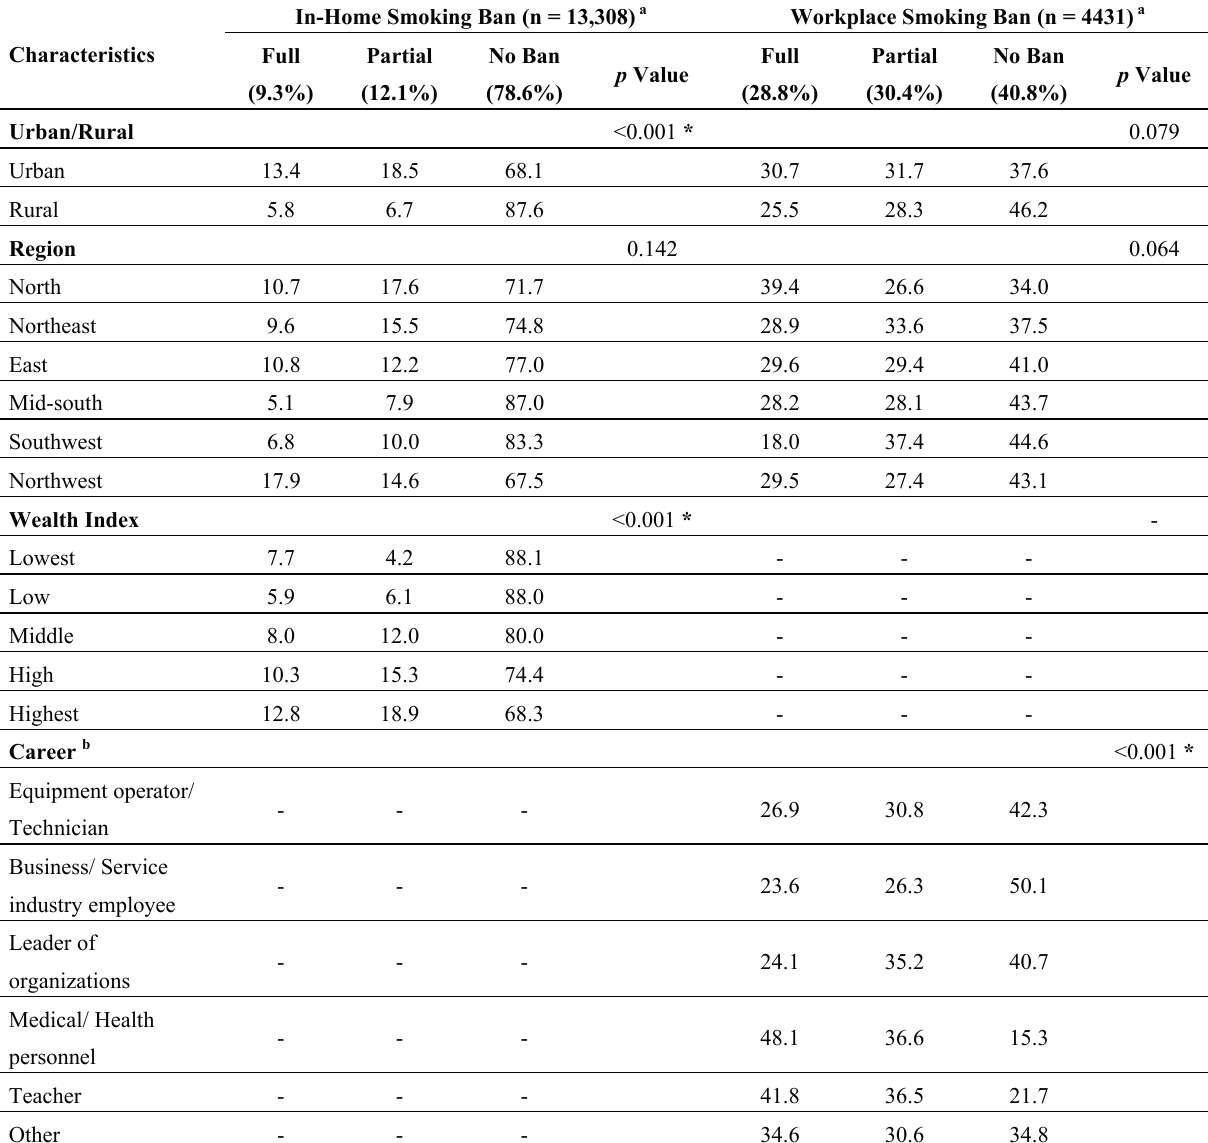
Table 3. Prevalence of smoking bans in home and at